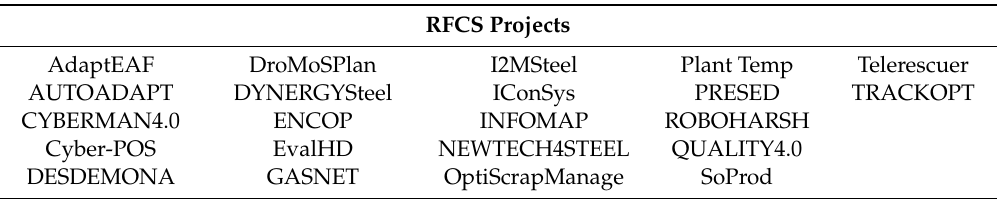
Table A1. List of acronyms identified RFCS Projects covering aspects of digitalization in the steel industry.